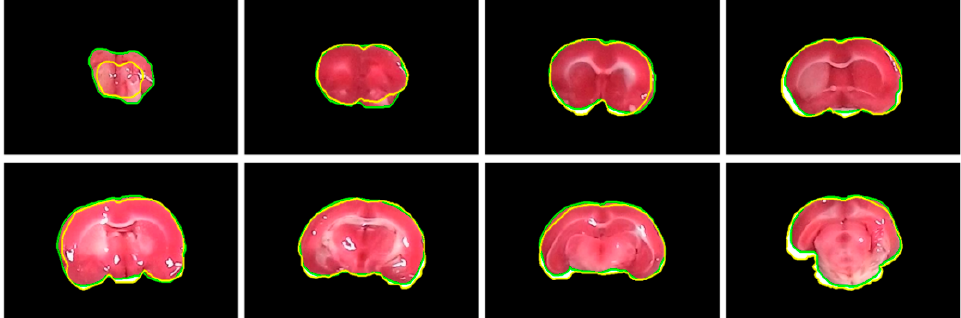
Figure 4. Visual comparison of subject 20 between our rat brain extraction contours (green) and the gold standard outlines (yellow). The brain extraction results were superimposed on the gold standard images with a dimension of 480 × 320 for all slices.